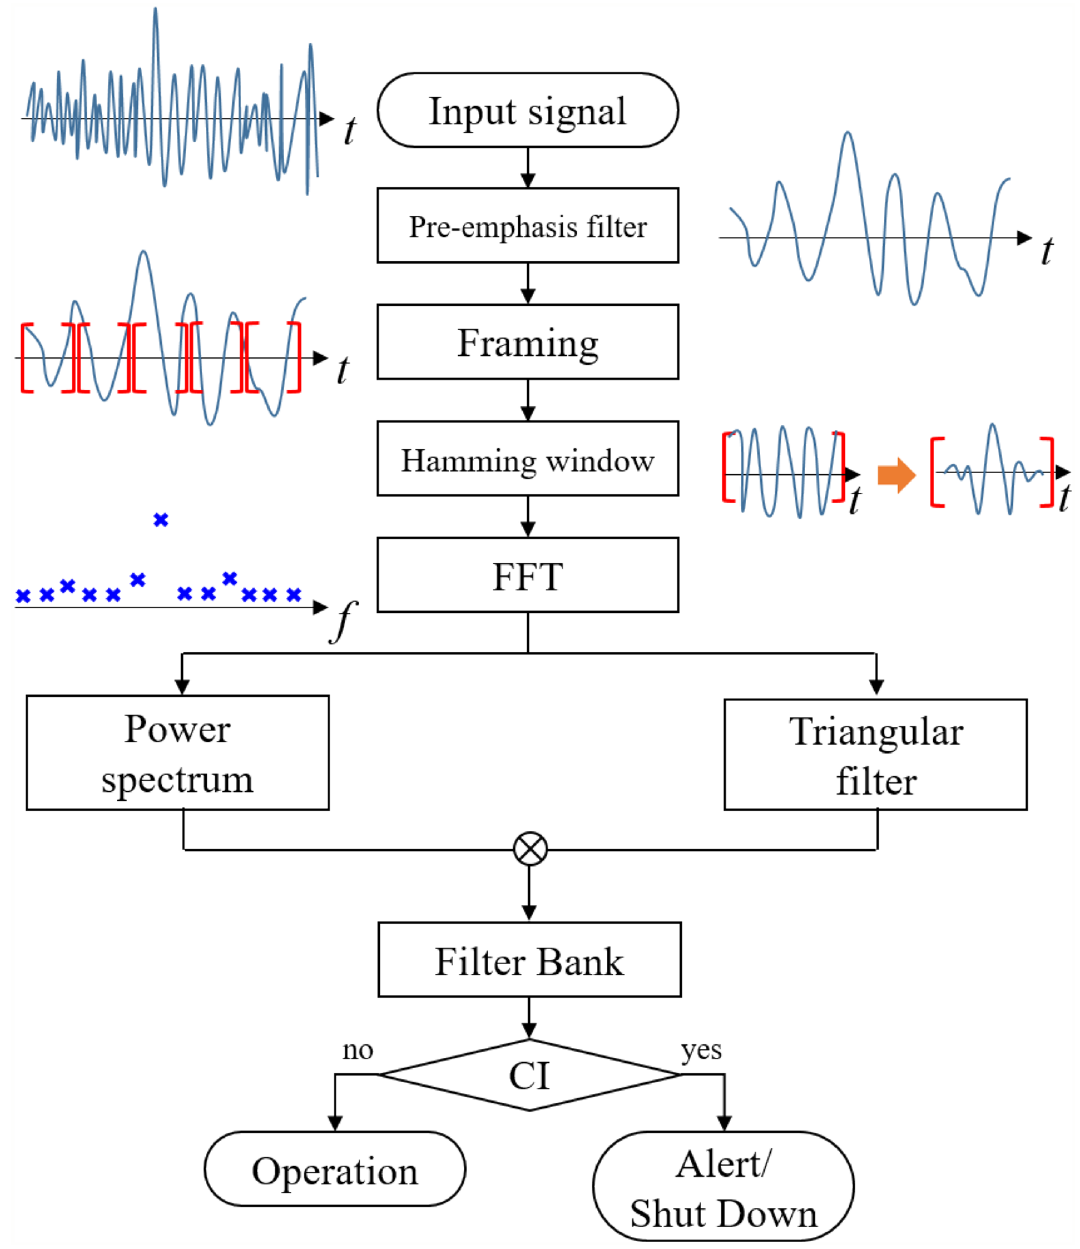
Figure 2. Flowchart of the FB processing method for CI